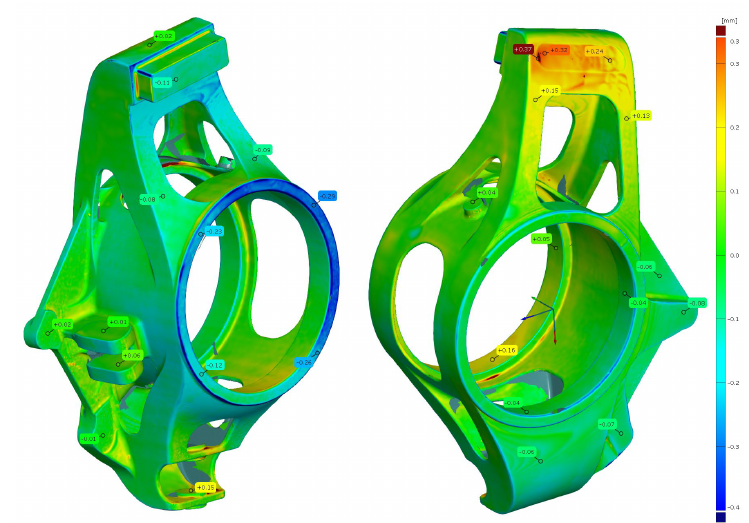
Figure 7. Dimensional changes of printed model (PMMA − BJ method).